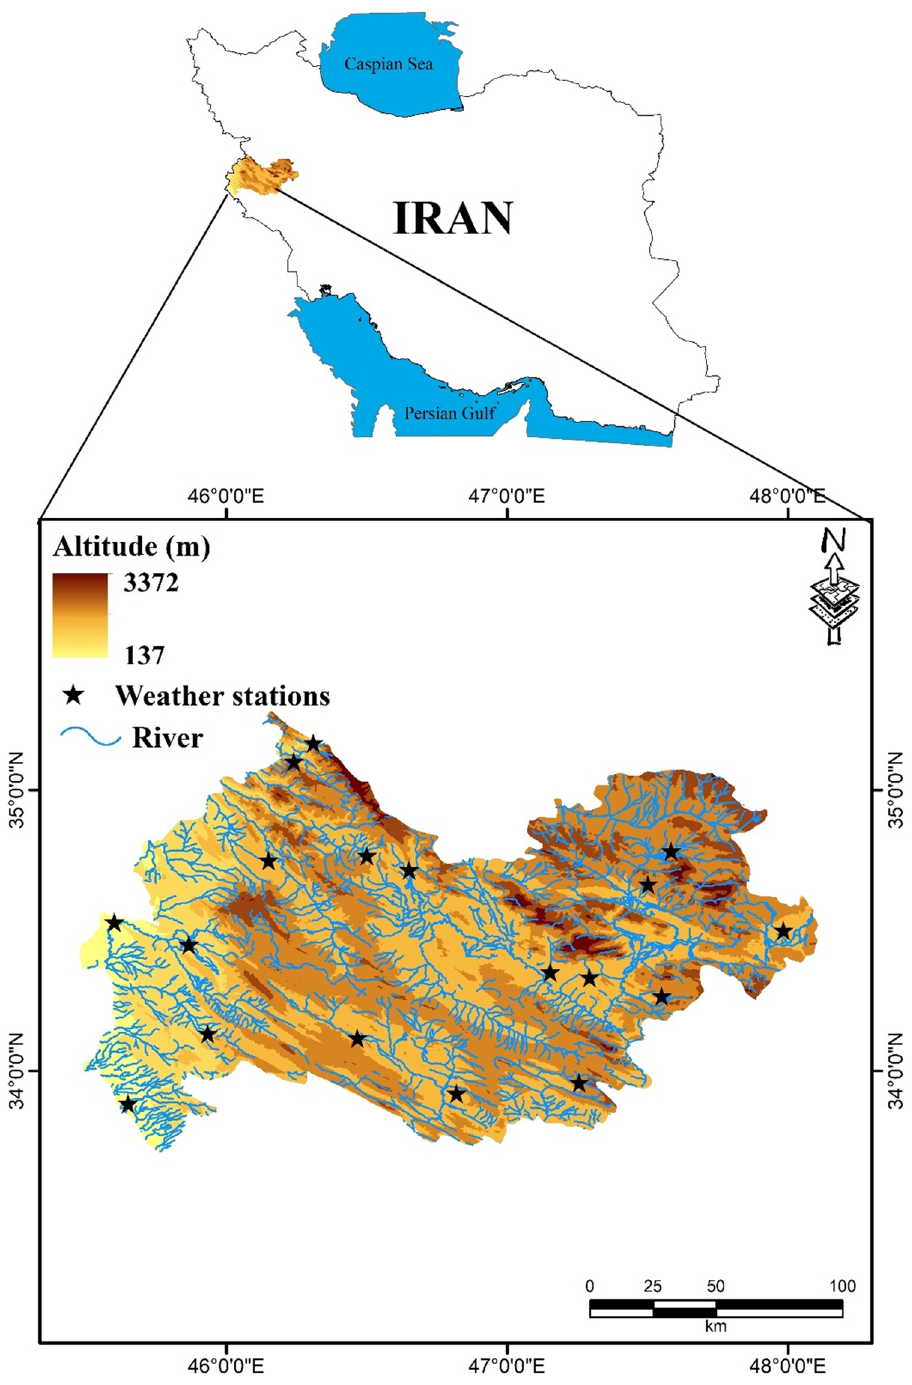
Figure 7. Location map of the Kermanshah province in Iran using ArcGIS 10.3.1